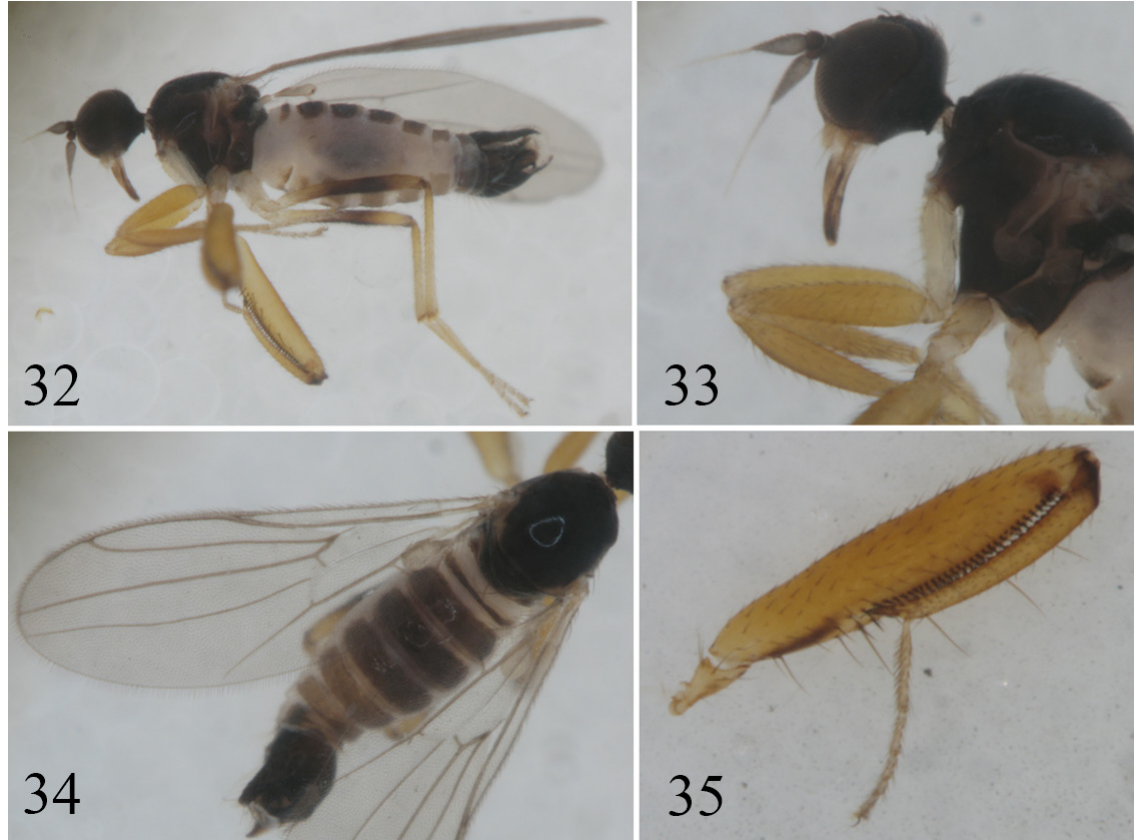
Figs 32–35. Platypalpus yangambensis sp. nov., paratype ♂. 32 . Habitus, lateral view. 33 . Head and thorax, lateral view. 34 . Wing. 35 . Mid leg, anterior